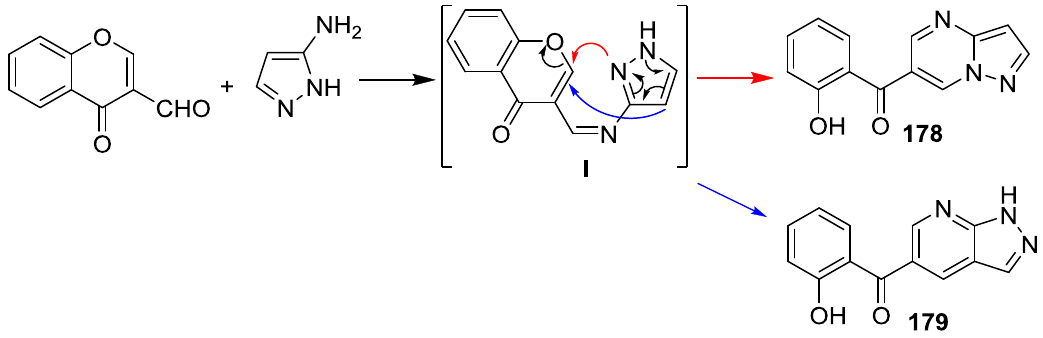
Scheme 61. Proposed mechanism for the synthesis of 6-(2-hydroxybenzoyl)pyrazolo[1,5- a ]pyrimidines 178 or 5-(2-hydroxybenzoyl)-1 H -pyrazolo[3,4- b ]pyridines 179 [117].